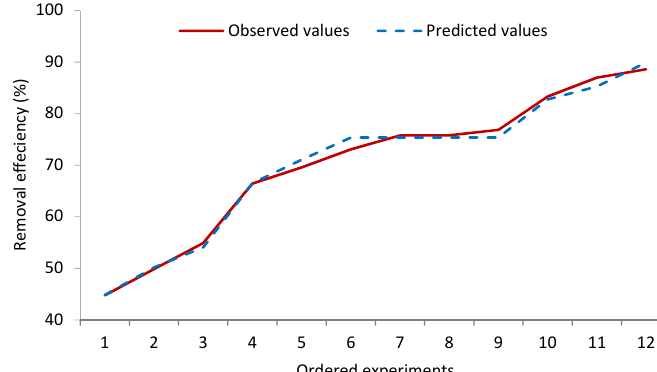
Fig. 1: Comparison of the observed experimented values and the model-predicted ones